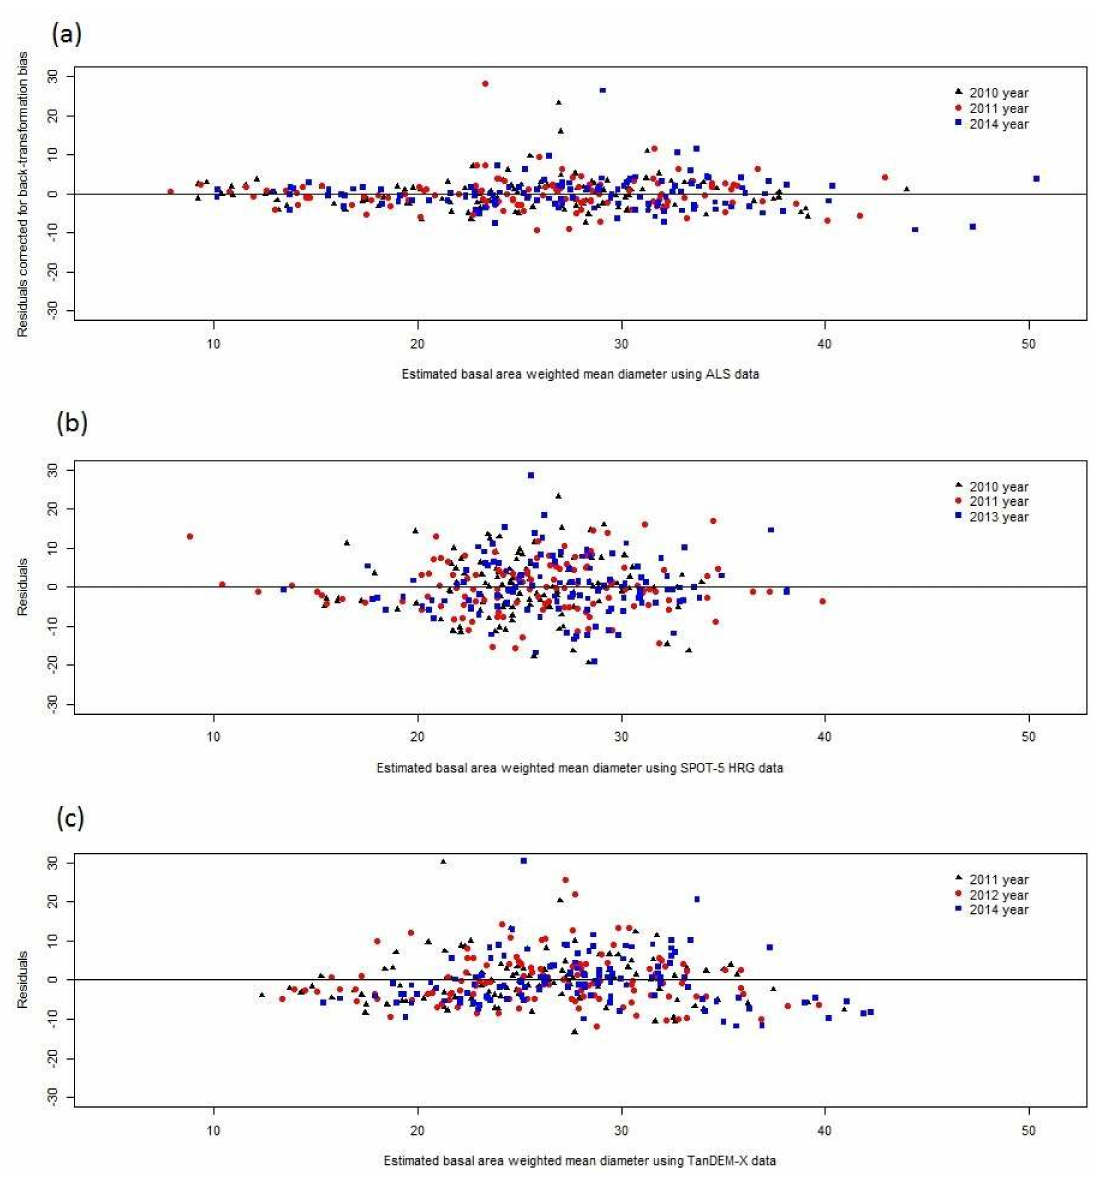
Figure A1. Estimated values versus residuals for estimated mean diameter using ( a ) ALS data fitted to “LOG-LOG” regression model, the residuals are calculated after back-transformation and corrected for bias; ( b ) SPOT-5 HRG data fitted to “LINEAR” regression model; ( c ) TanDEM-X data fitted to “LINEAR” regression